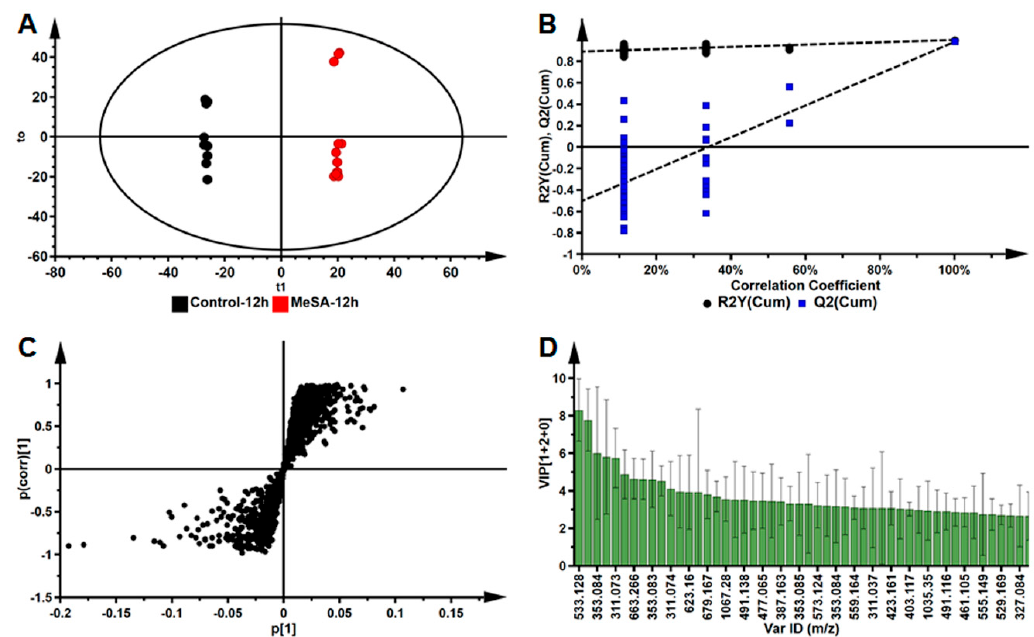
Figure 3. An orthogonal projection to latent structures discriminant analysis (OPLS-DA) model of control (black) and 0.5 mM MeSA (red) treated leaf extracts at 12 h post-treatment. ( A ) A scores plot summarizing the relationship between the two conditions. ( B ) A permutation test plot (n = 50) in response to the OPLS-DA plot indicated in ( A ), with quality parameters indicated on the y -axis intercepts of the figure: R 2 = (0.0, 0238) and Q 2 = (0.0, − 0.450). ( C ) A loadings S-plot, with statistically significant features described to have (p (corr)) of ≥ 0.5 and covariance of (p1) ≥ 0.5. ( D ) A variable importance in projection (VIP) plot for the OPLS-DA model. Significant ions are indicated by a VIP score > 1.0. The computed OPLS-DA was significant, validated by a p- value = 7.92 × 10 − 7 .